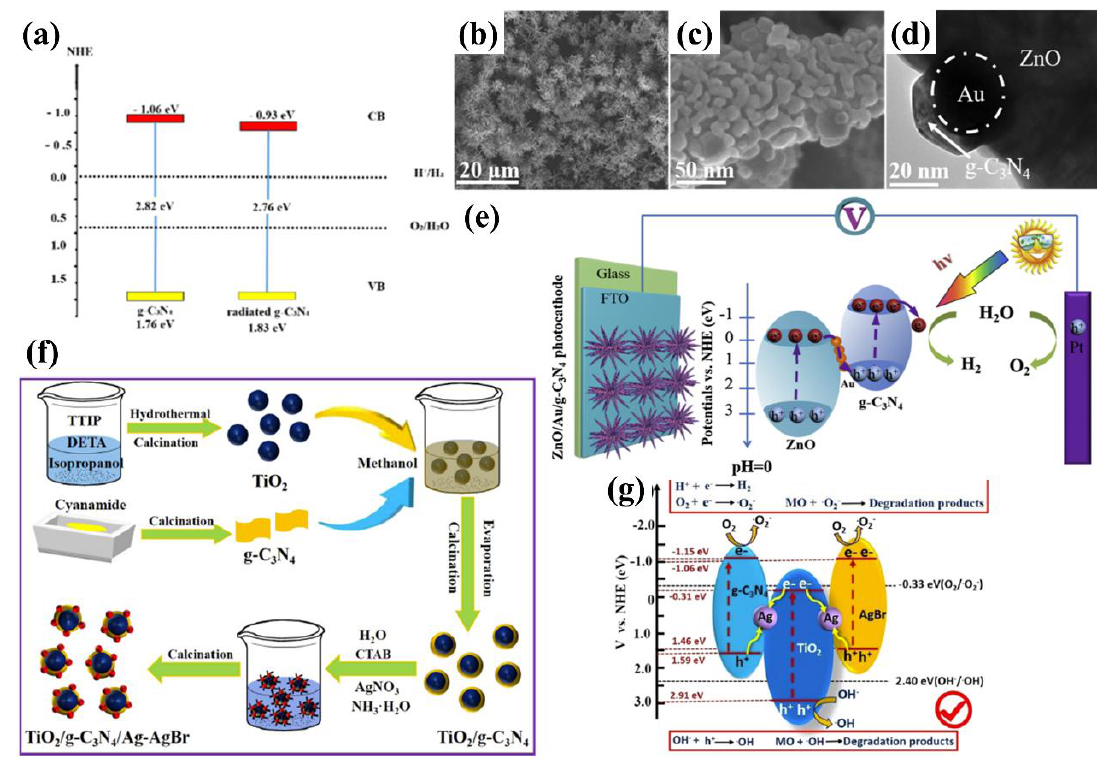
Figure 26. ( a ) Schematic representation of the band structures of g − CN and γ radiated g − CN. Reprinted with permission from ref. [245] Copyright 2019 American Chemical Society. SEM images of the low-magnification ( b ) and high-magnification ( c ) of the 3D urchin-like ZnO/Au/g − CN. ( d ) TEM image of 3D urchin-like ZnO/Au/g − CN. ( e ) Schematic illustration of the PEC reaction mechanism of the 3D urchin-like ZnO/Au/g − CN photocathode. Reprinted with permission from ref. [253] Copyright 2020 Elsevier. ( f ) The fabrication process of composite. ( g ) Possible photocatalytic reaction process and charge transfer of the composite. Reprinted with permission from ref. [254] Copyright 2022